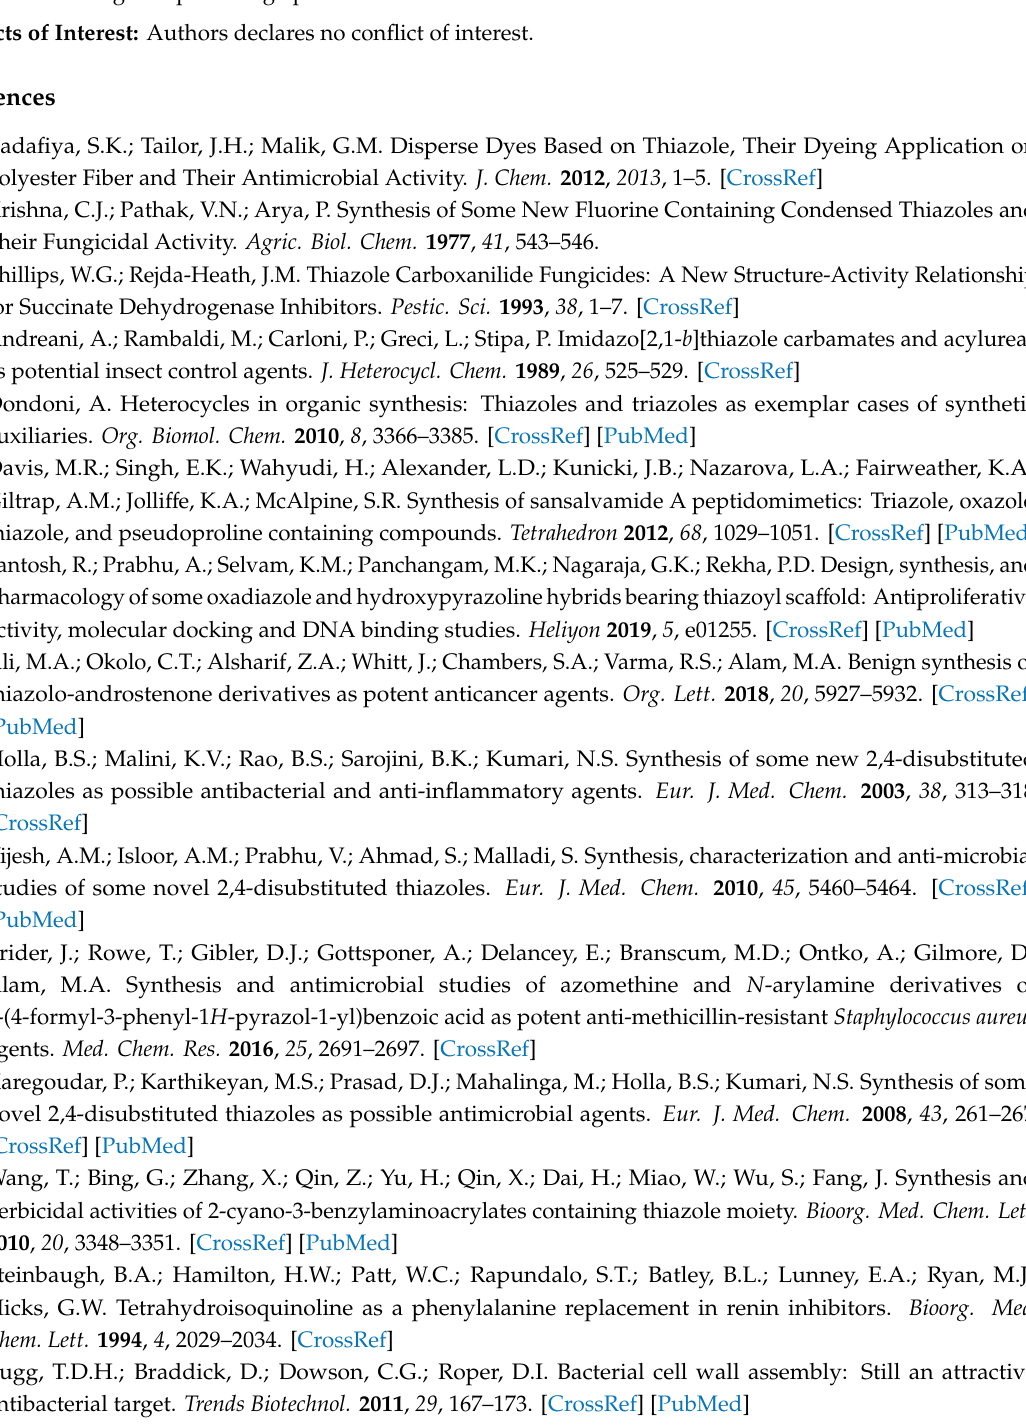
Figure S1: FT-IR, Figure S2: LC-MS, Figure S3: 1 H-NMR, Figure S4: 13 C-NMR, Figure S5: Absorption spectra were available